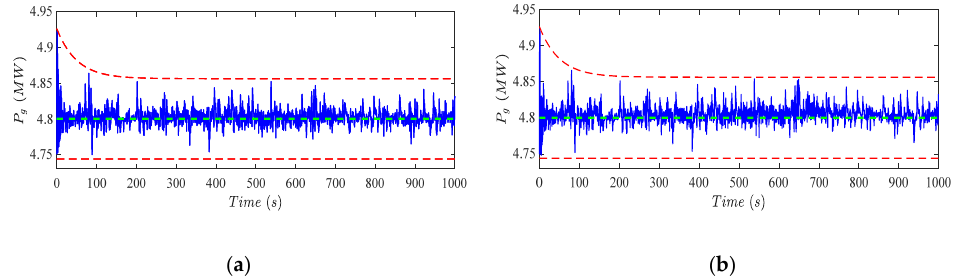
Figure 8. Generated power P g (blue line) with constructed constraints (red dashed lines) and nominal value (green dashed line), under single ( a ) and simultaneous faults ( b